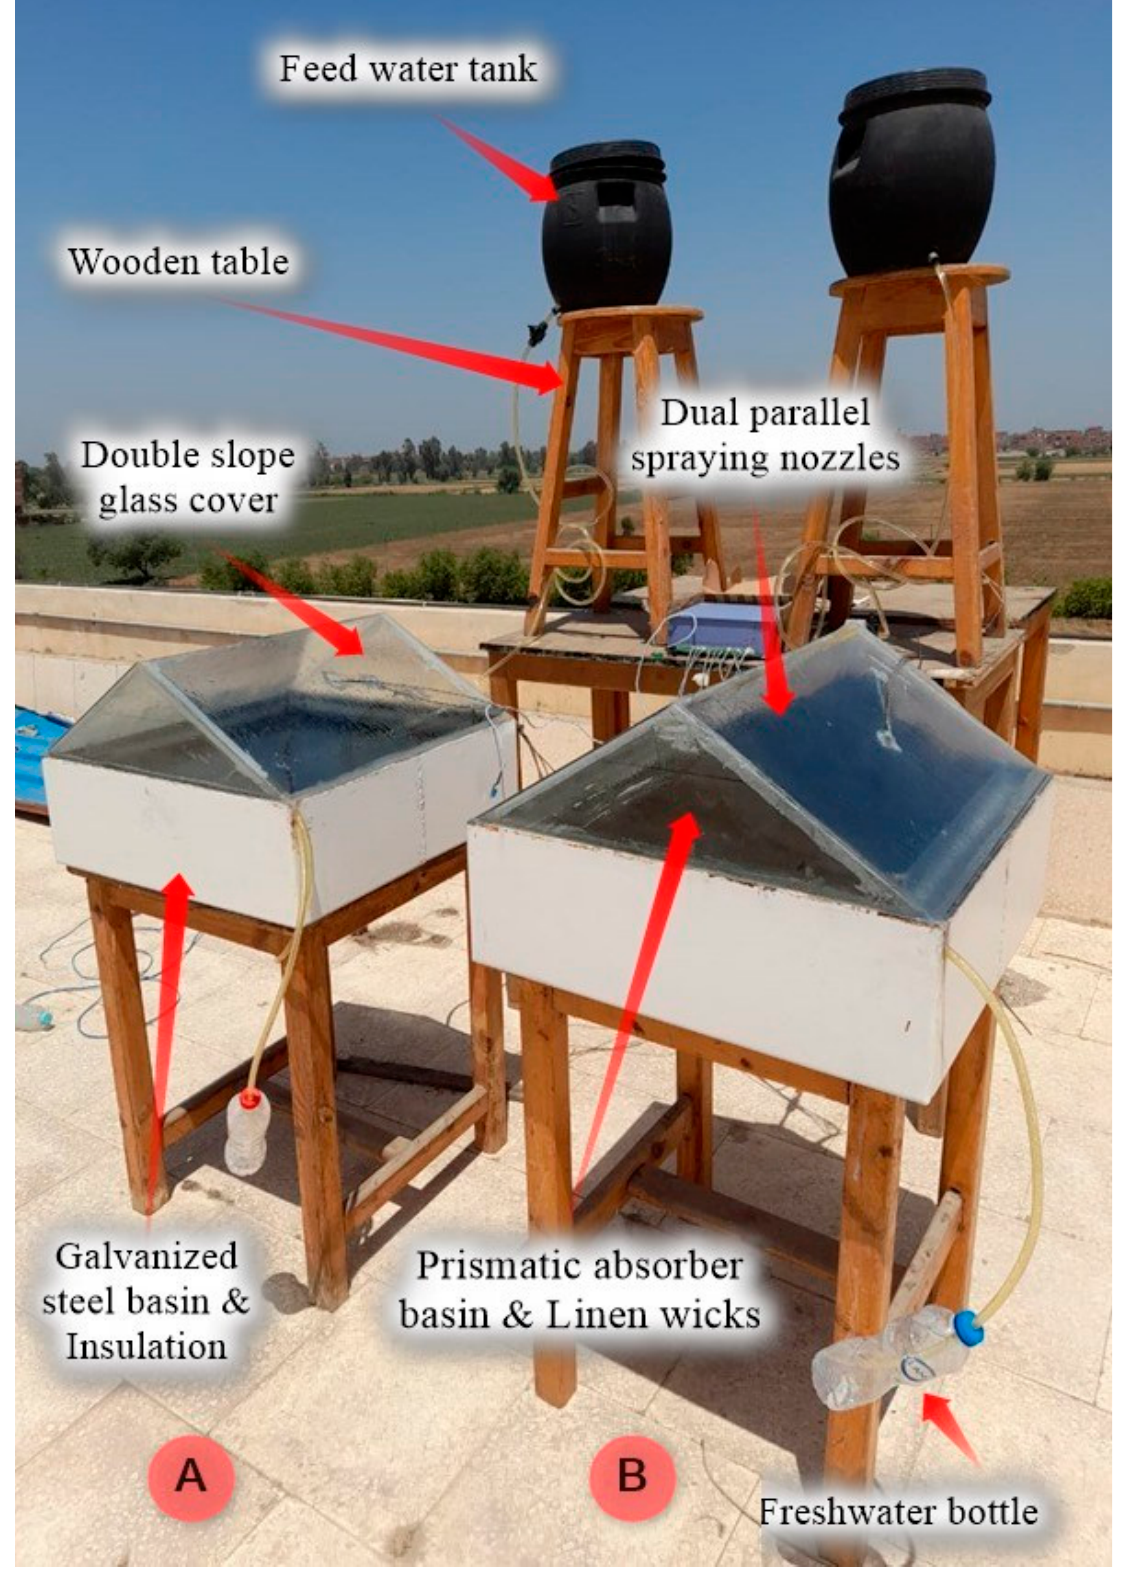
Figure 2. Photographic view of the test-rig of TDSSD (left) and DSSD-WPB&DPSN (right).